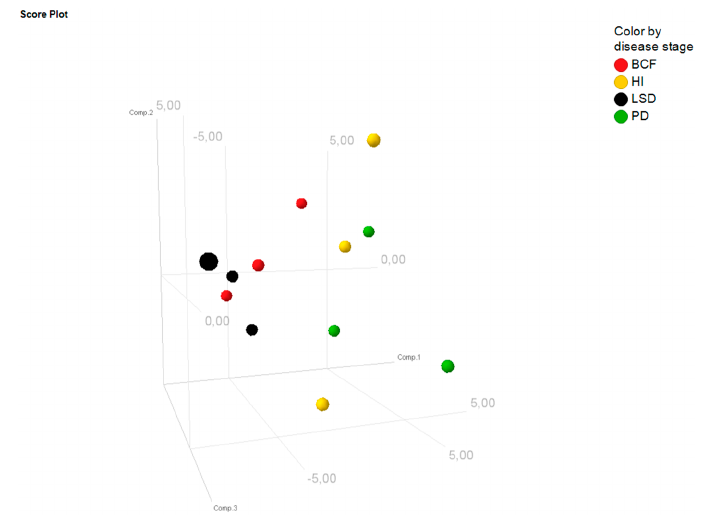
Figure 2. Principal component analysis. Displayed are the first three major components from the principal component analysis for each replicate per time point: PD = pre-diabetes; HI = hyperinsulinemia; BCF = β cell failure; LSD = late-stage diabetes.